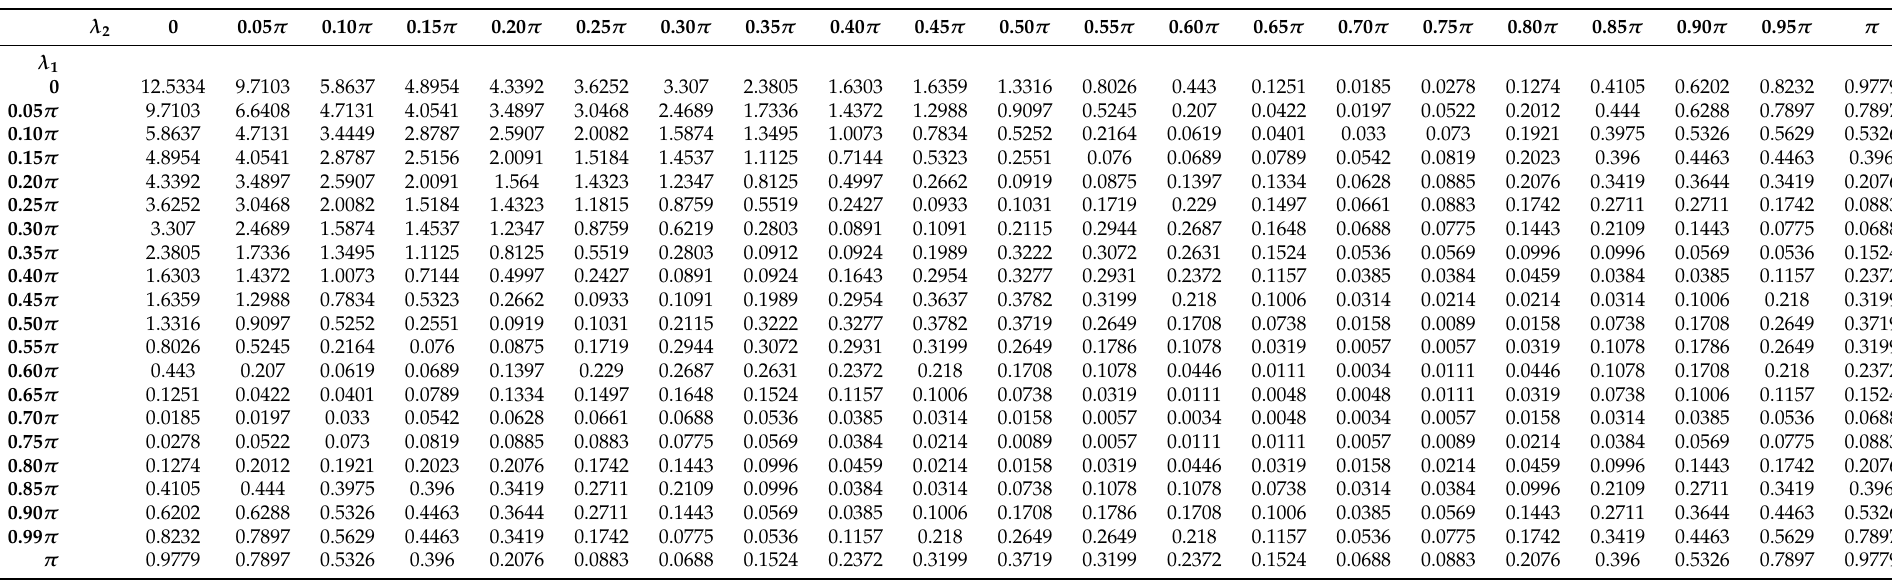
Table 5. Numerical values of smoothed multitapered biperiodogram of DCGINAR(1) model with M = 15 and β =